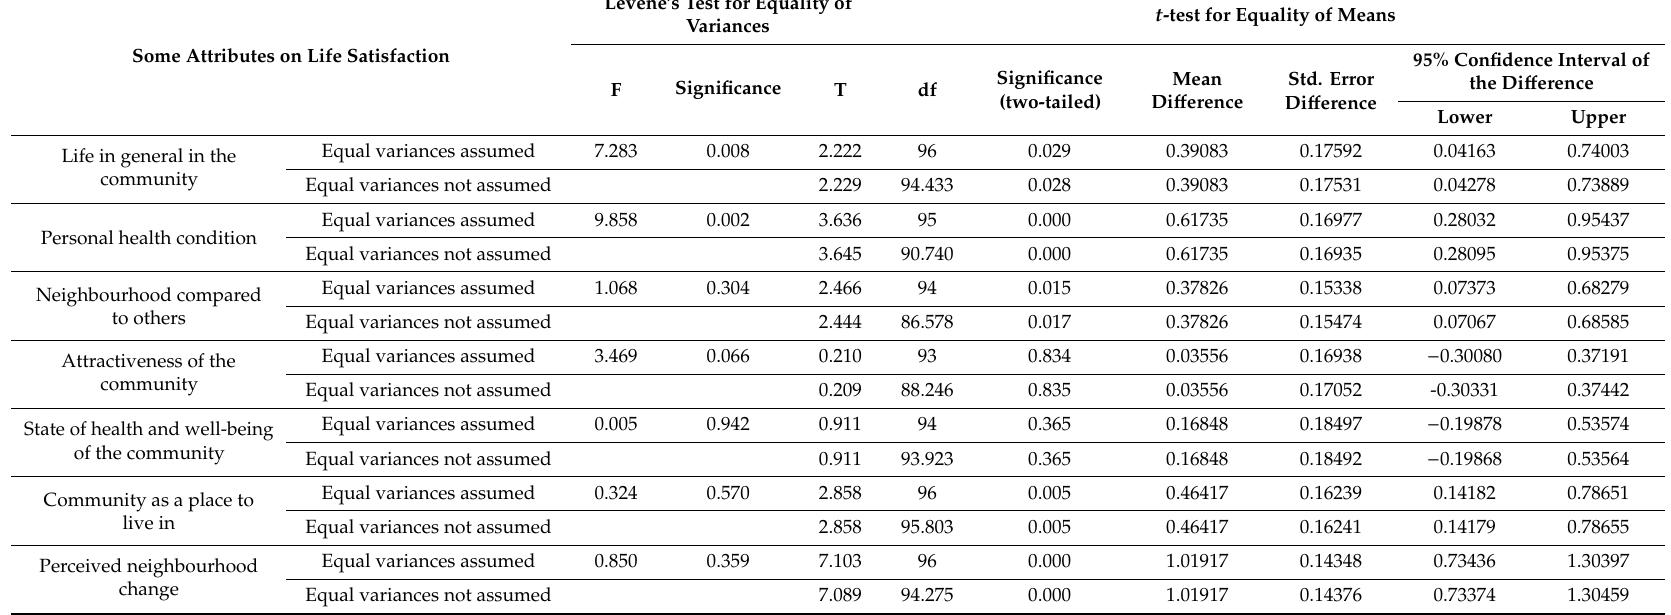
Table A4. Independent samples test on life satisfaction with living in the